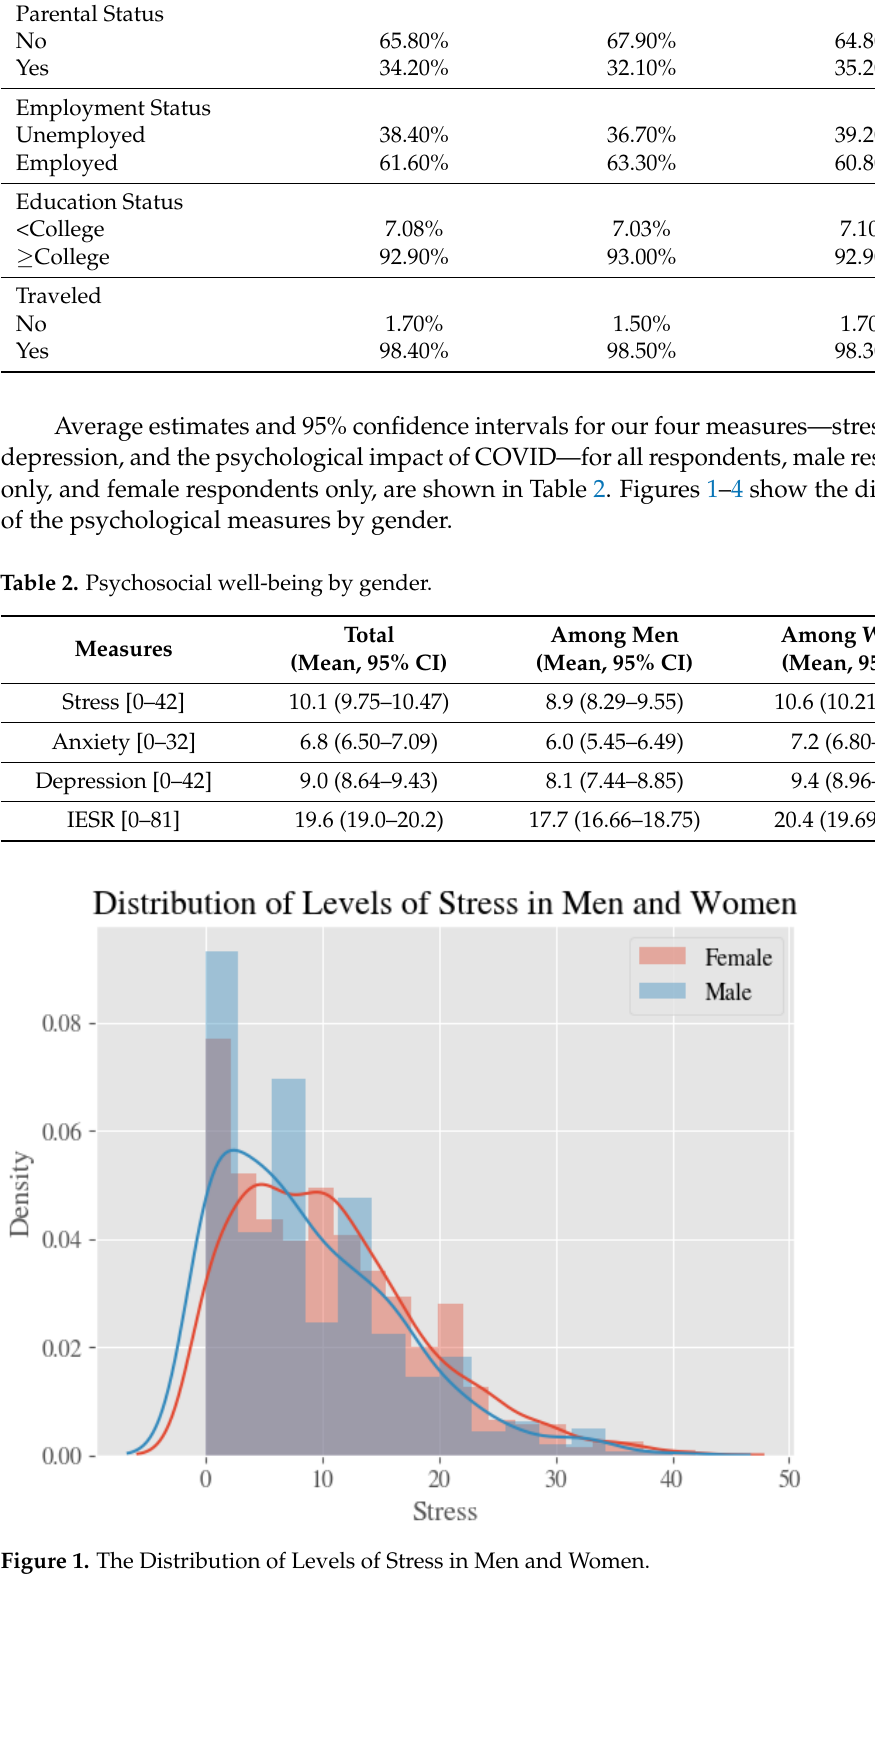
Figure 2. The Distribution of Levels of Depression in Men and Women.